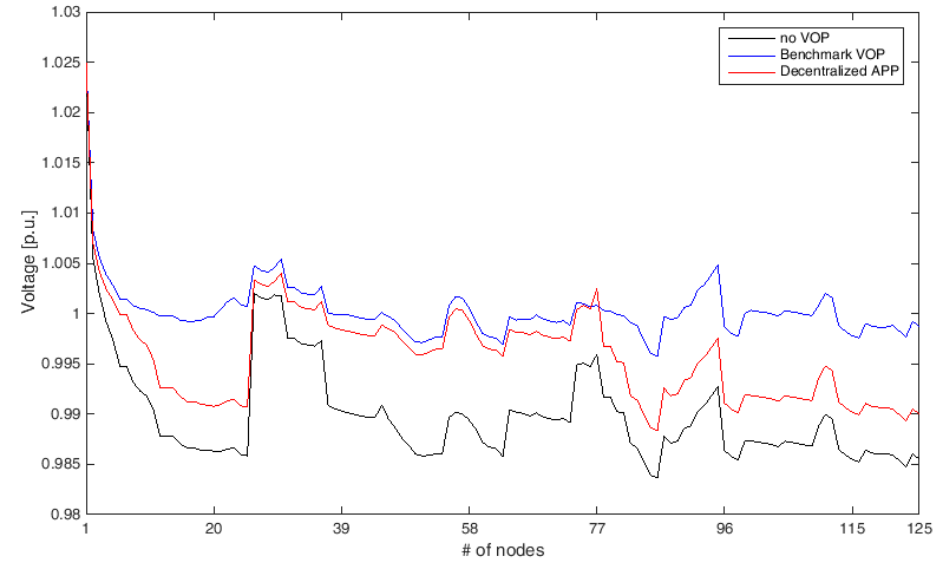
Figure 15. The network voltage profile for the no VOP , Benchmark VOP and Decentralized APP in Case 1